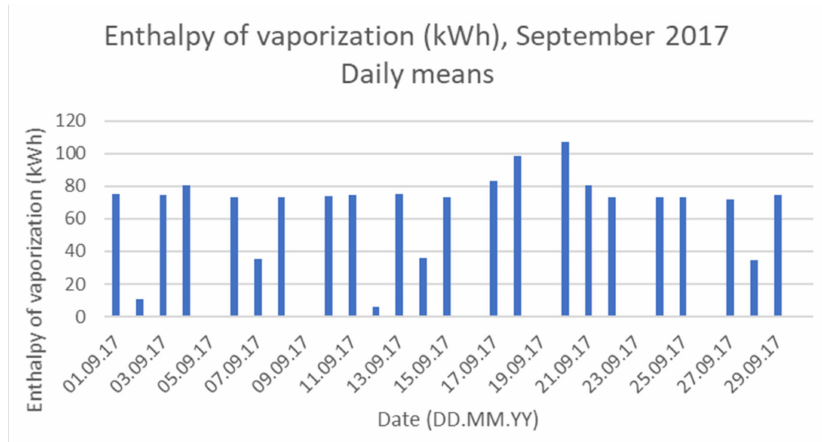
Figure 8. Daily mean values of evaporation energy (kWh) in September 2017.